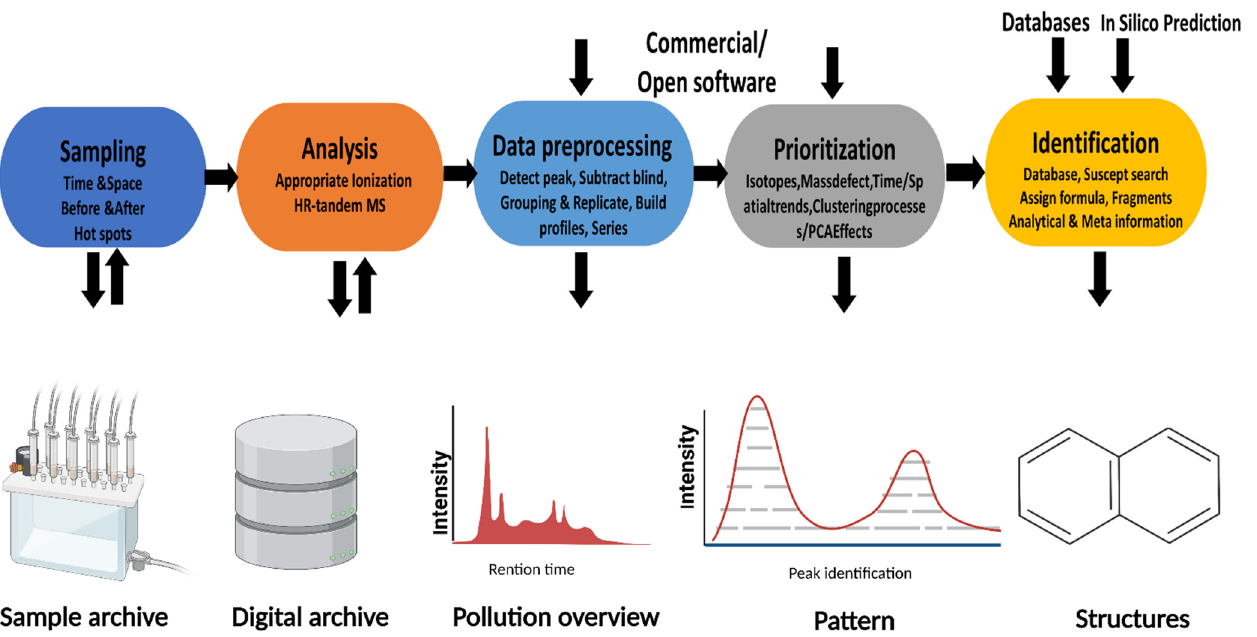
Figure 3. Workflow for non-target screening to identify non-targeted peaks with feasible molecular